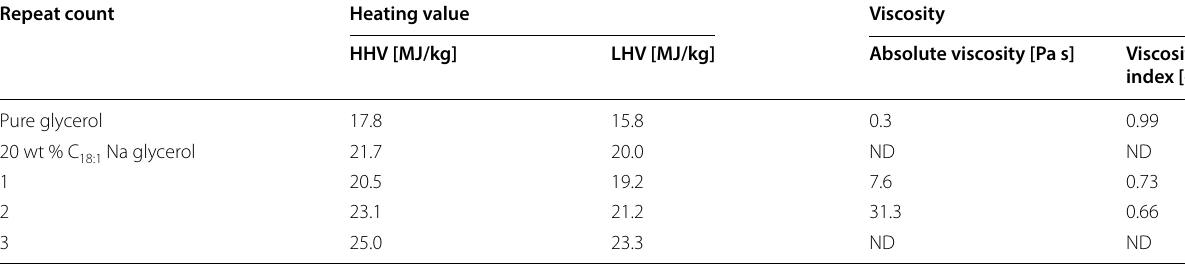
Table 5 Heating values and viscosities of glycerol fuels and effect of repeated delignification